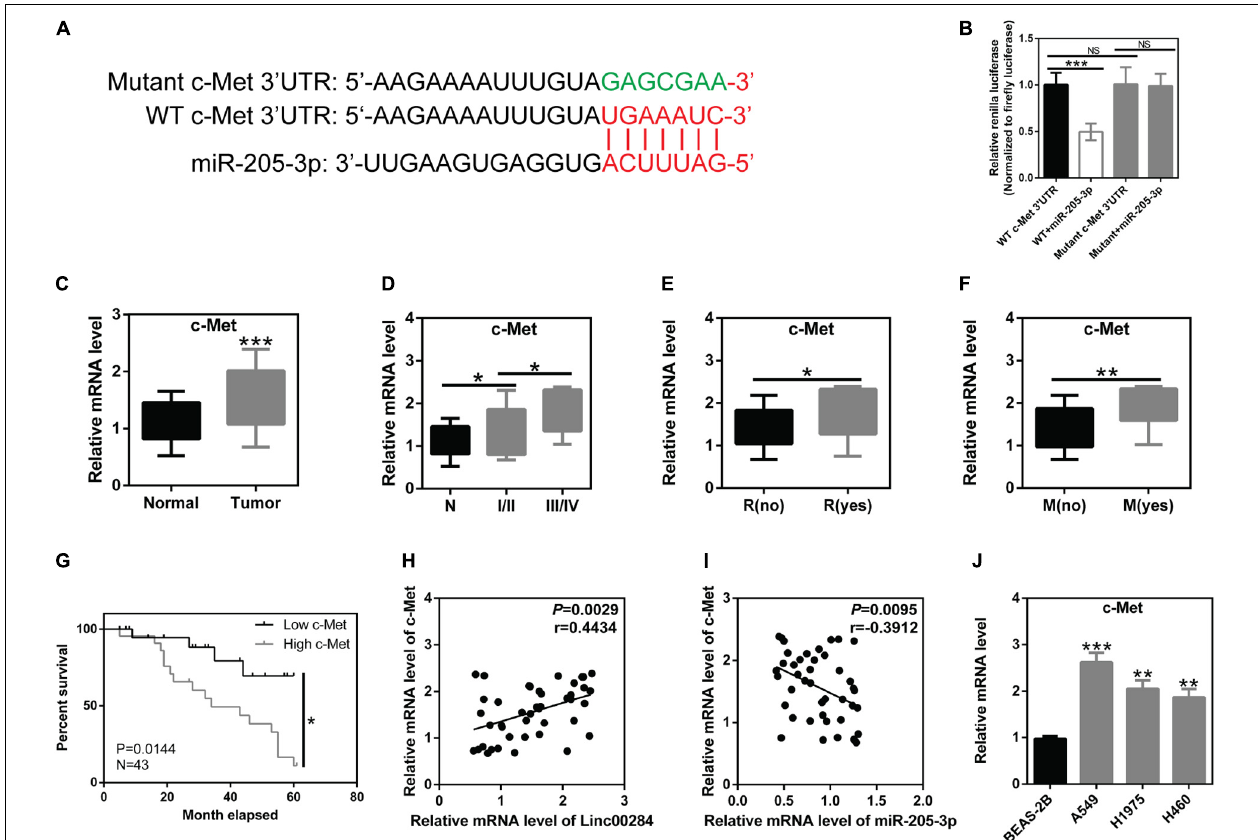
FIGURE 5 | c-Met is the direct target of miR-205-3p. (A) Schematic diagram of the binding sites between miR-205-3p and the 3 (cid:48) UTR of c-Met mRNA. Red indicates the predicted binding sites between c-Met and miR-205-3p. Green indicates the mutant sequence of c-Met. (B) A direct interaction between miR-205-3p and the 3 (cid:48) UTR of c-Met mRNA. (C) Significant upregulation of c-Met in 43 human lung cancer tissues and patient-matched normal tissues. (D–G) c-Met expression was associated with (D) TNM stage, (E) recurrence, (F) metastasis, and (G) overall survival of patients with lung cancer. (H) Pearson’s correlation analysis revealed that c-Met expression was positively correlated with the Linc00284 level in human lung cancer tissues. (I) c-Met expression was negatively correlated with the miR-205-3p level in human lung cancer tissues. (J) mRNA levels of c-Met were significantly upregulated in A549, H1975, and H460 lung cancer cell lines. Data are expressed as the means ± SD of triplicate independent experiments. The expression of c-Met in 43 lung cancer tissues and paired adjacent non-cancerous tissues was analyzed using paired t -test. Multiple comparisons were analyzed by one-way ANOVA followed by Tukey’s test. Kaplan–Meier analysis was used for survival analysis. Correlation analysis was assessed using Pearson’s correlation analysis. * P < 0.05, ** P < 0.01, and *** P < 0.001, compared with the matched control group. NS, not significant. N, adjacent normal tissues; T, tumor tissues; R, recurrence; M,